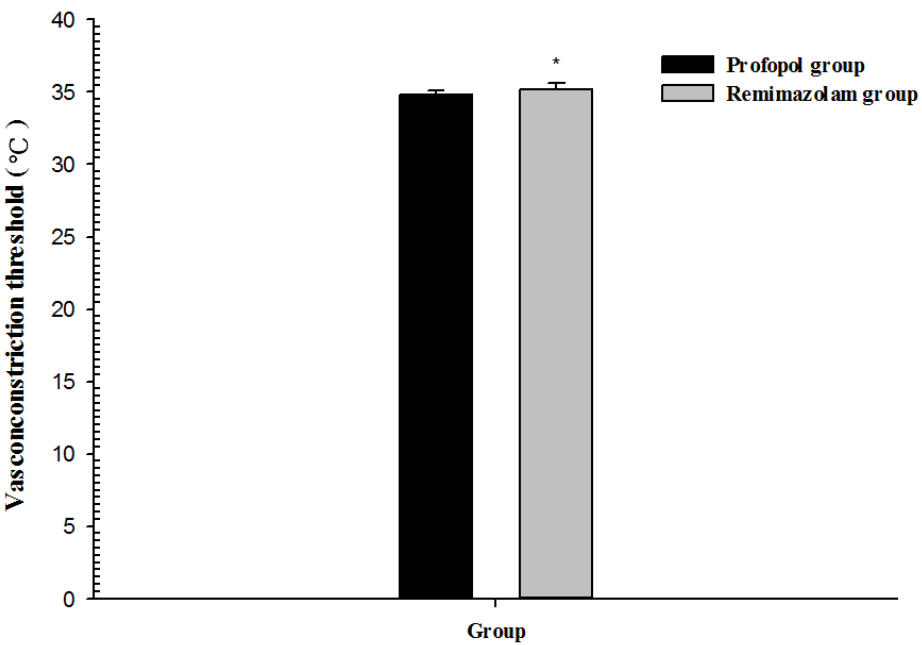
Figure 2. Vasoconstriction threshold after induction of general anesthesia with propofol or remima- zolam; * p < 0.01 vs. propofol group.